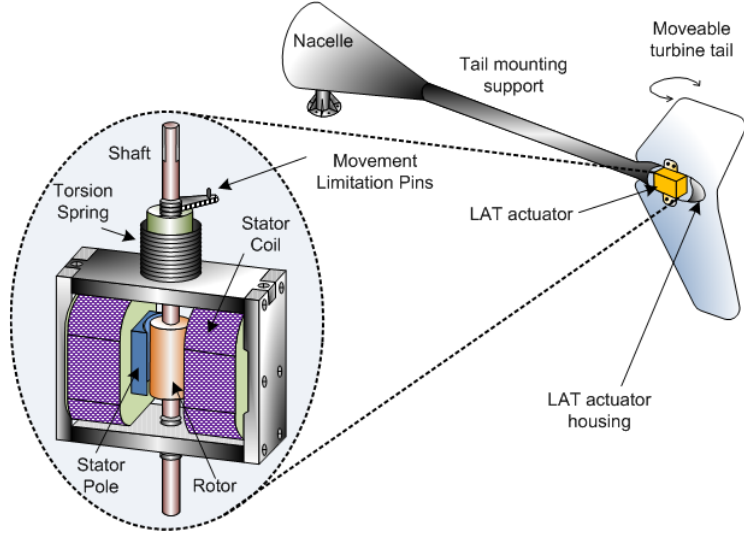
Figure 9. Limited-angle torque actuator (LAT)